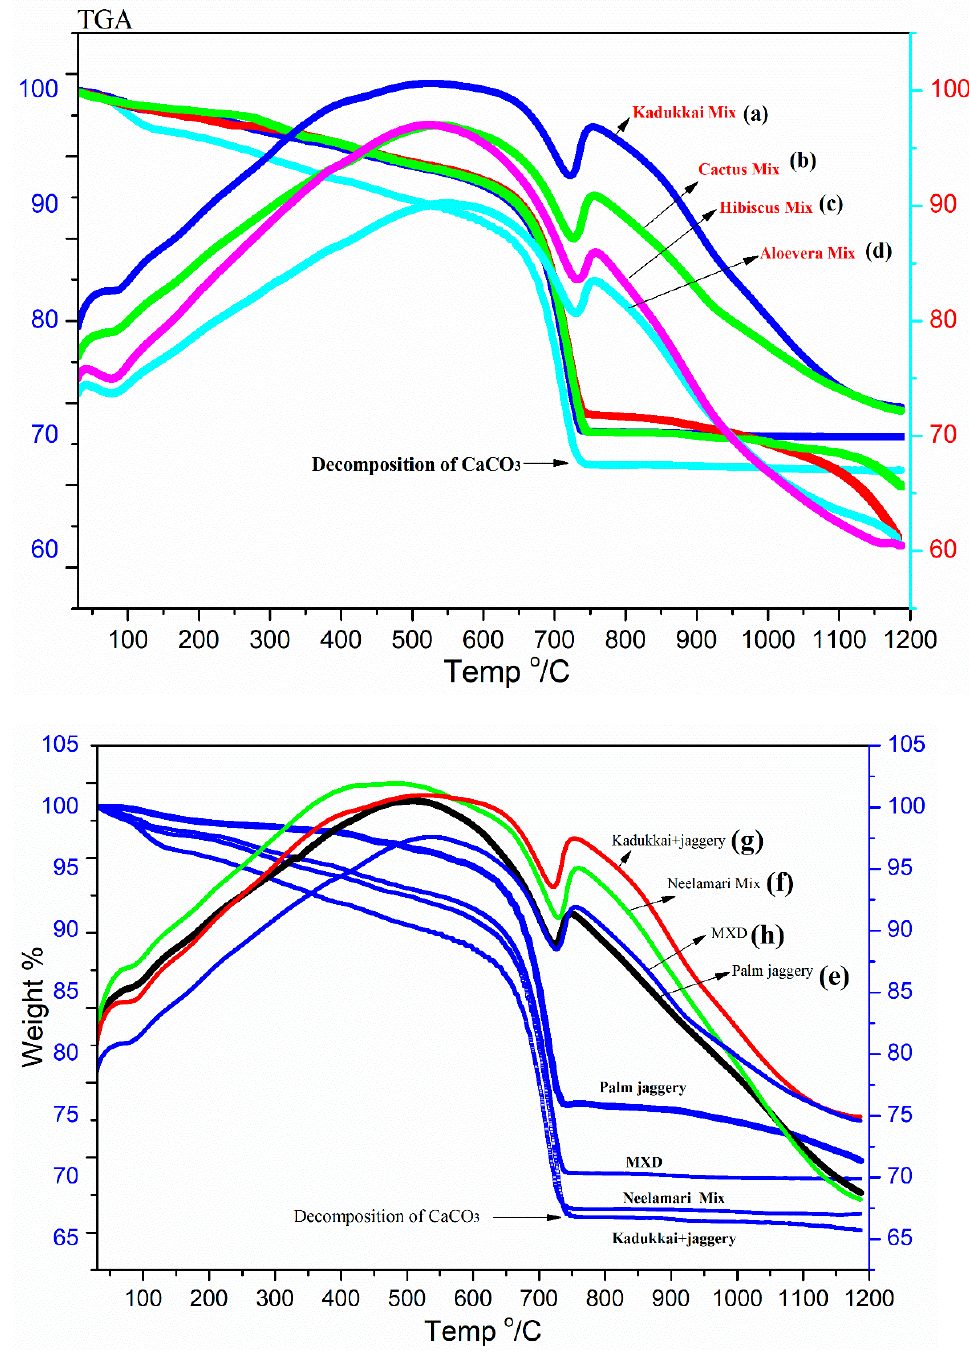
Figure 4. TG-DTA of 56-days mortars LM-2 Reference mortar: ( a ) kadukkai; ( b ) cactus; ( c ) hibiscus; ( d ) aloe vera; ( e ) jaggery; ( f ) neelamari; ( g ) kadukkai + jaggery; and ( h ) kadukkai + jaggery + aloe vera (MXD).